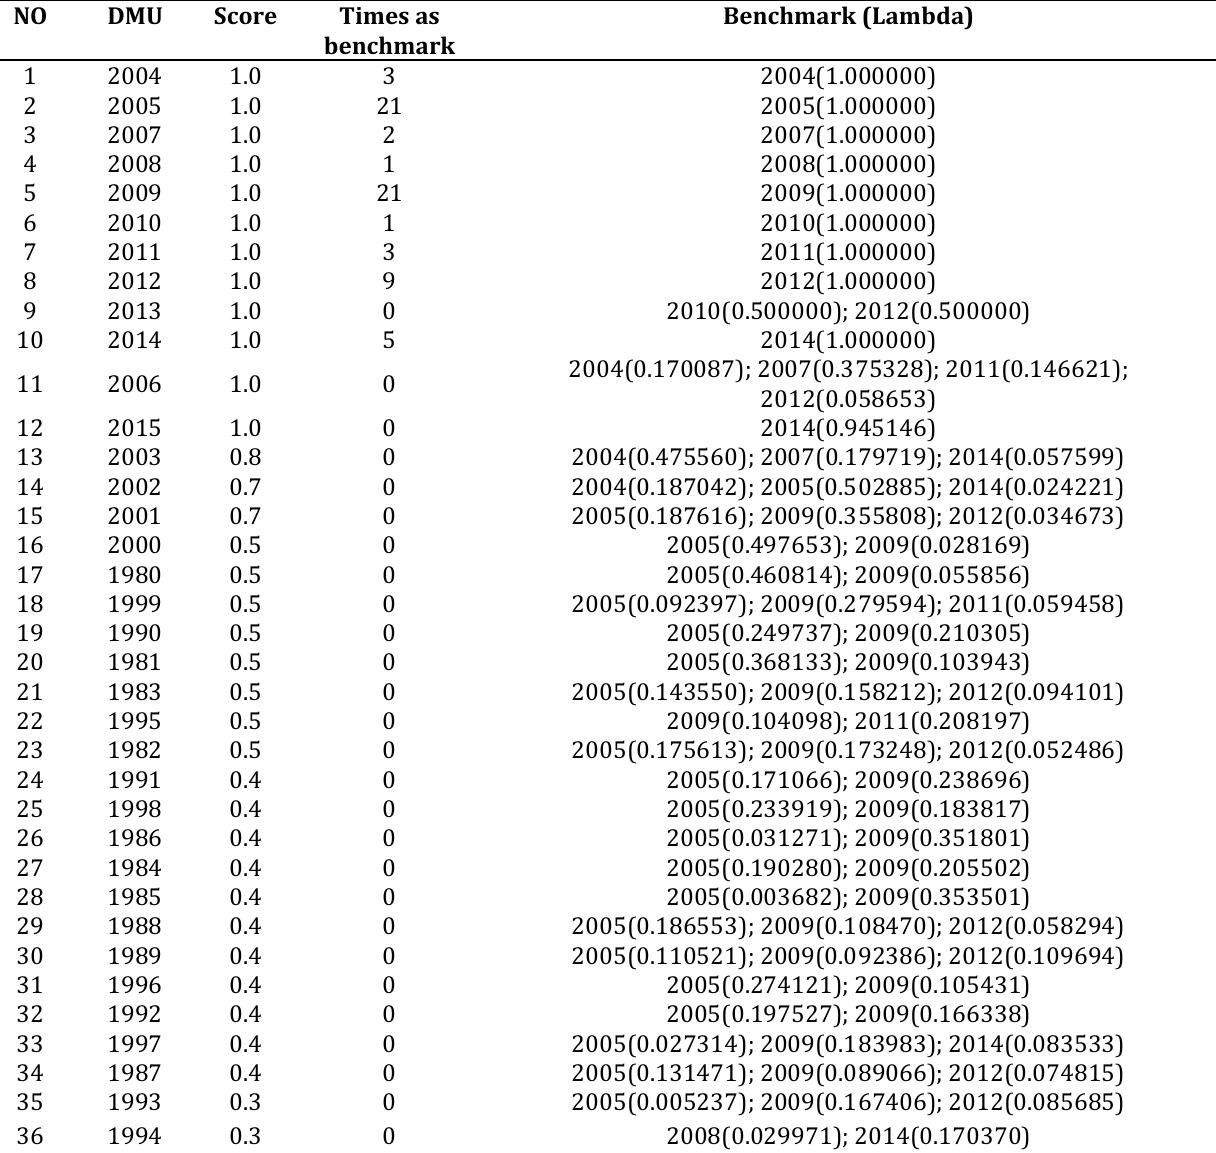
Table 7: Input-Oriented Technical Efficiency Benchmarking for Rivers Port